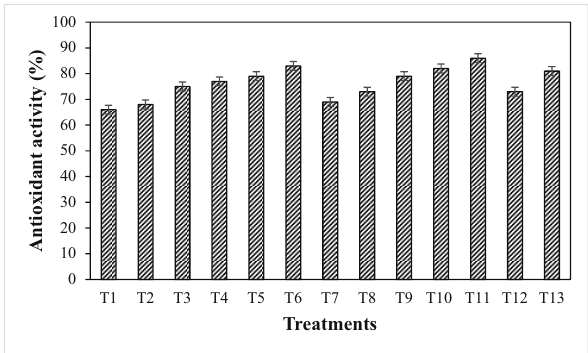
Figure 9: E ff ect of di ff erent treatments of NPs alone or in combina - tion with TDZ on antioxidant activity in callus cultures of A. absinthium